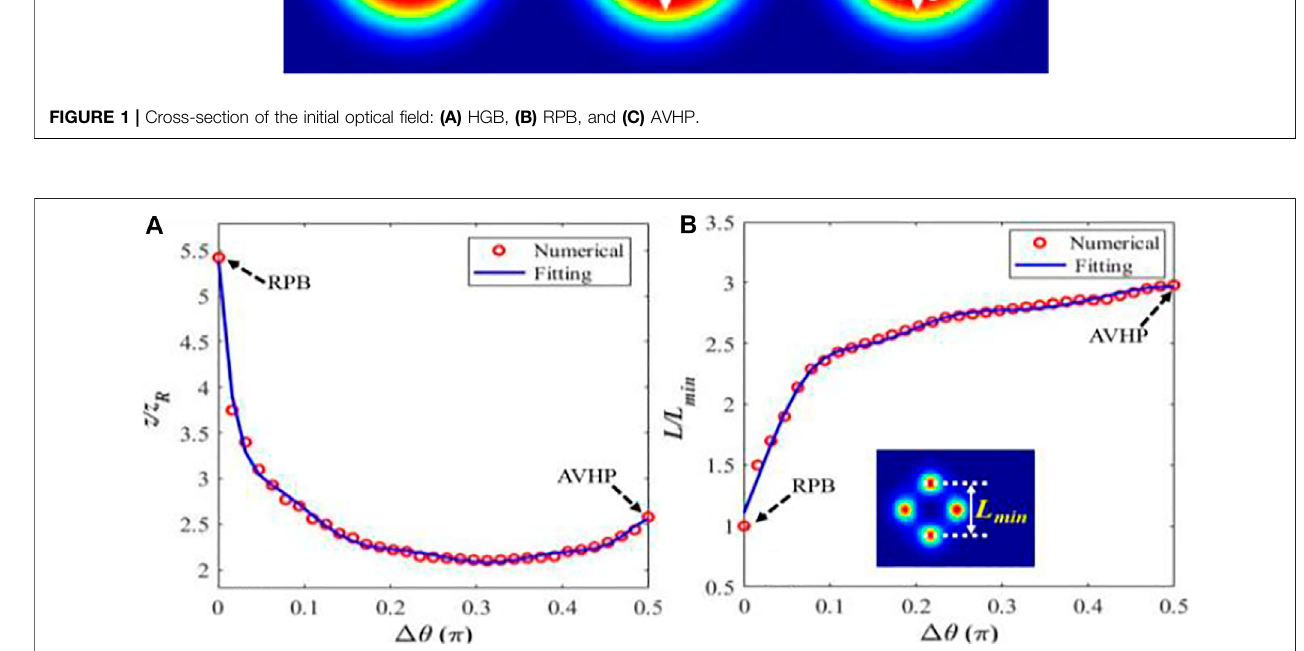
FIGURE 2 | SFL (A) and spacing (B) of self-focusing spots versus the phase difference.